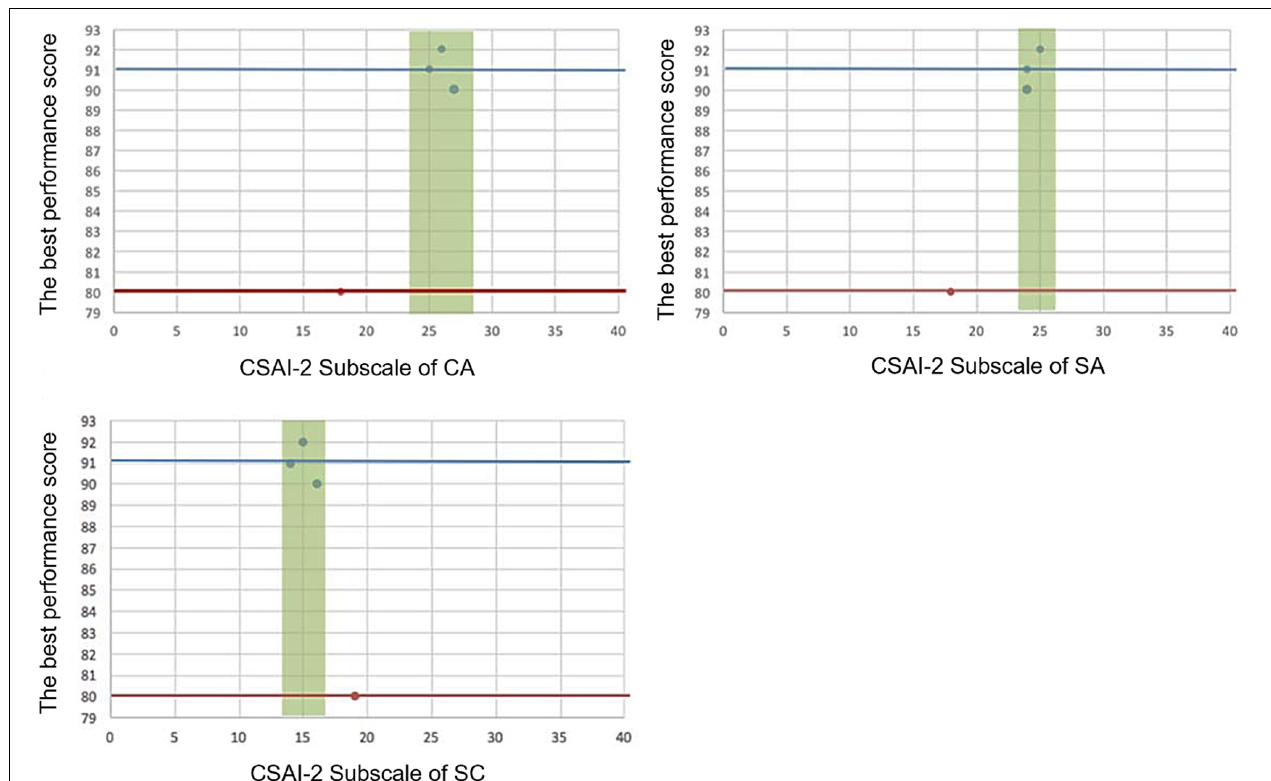
FIGURE 2 | The best performance scores and CSAI-2 subscales for participant #14. The green band represents the IZOF of participant #14. The red and blue horizontal lines represent the lowest and highest scores of the best performance scores. The blue spots indicate the performance scores.